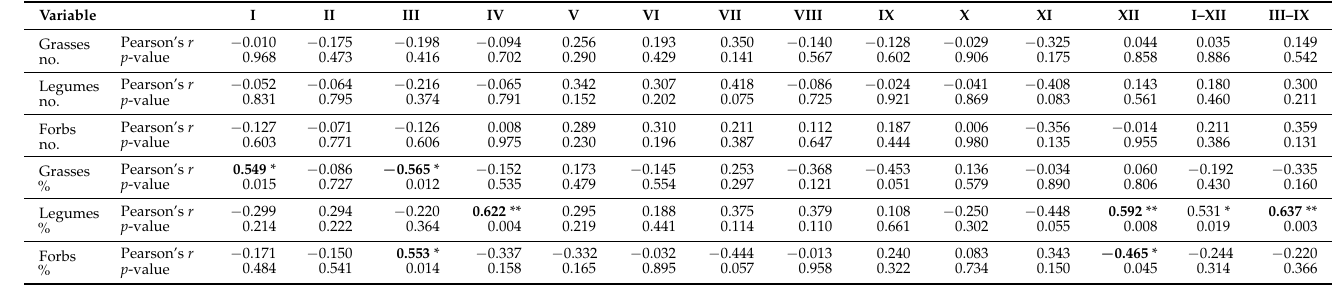
Table 4. Correlations between the rainfall amounts (I–XII) and floristic composition in ex-arable grassland from Gr ă dinari (period